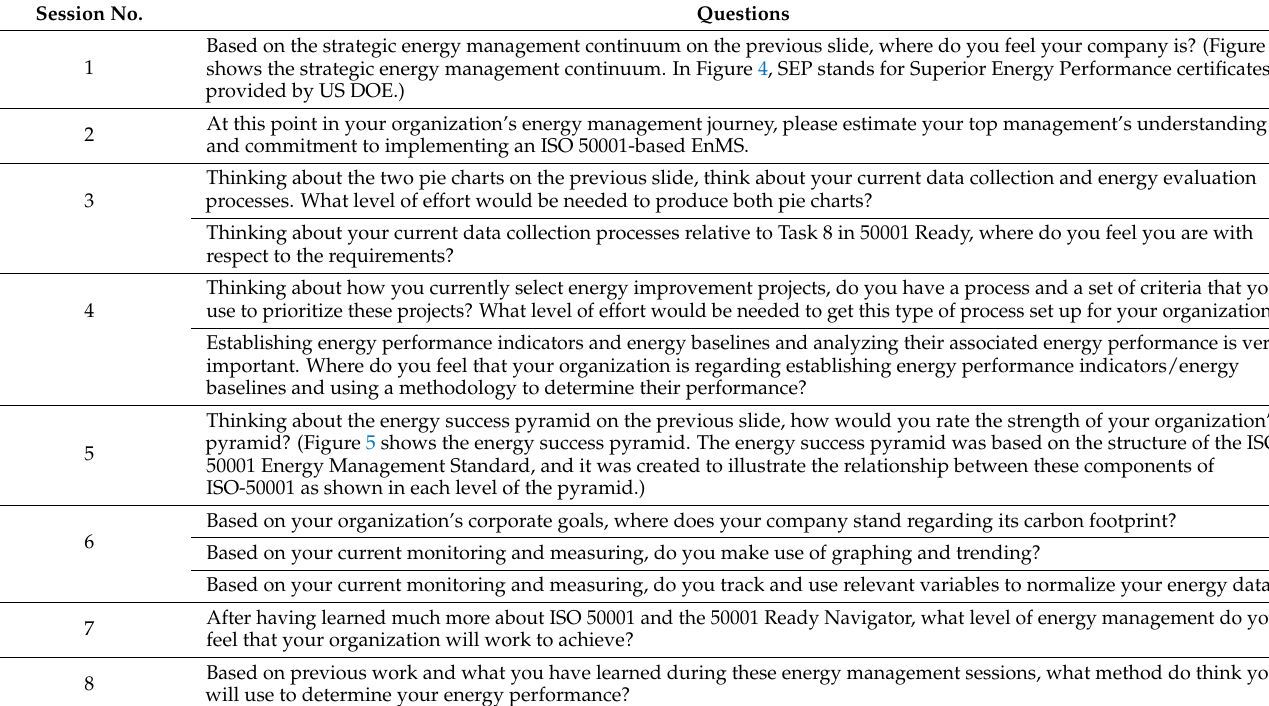
Table 3. Group 3 questions (source: author’s